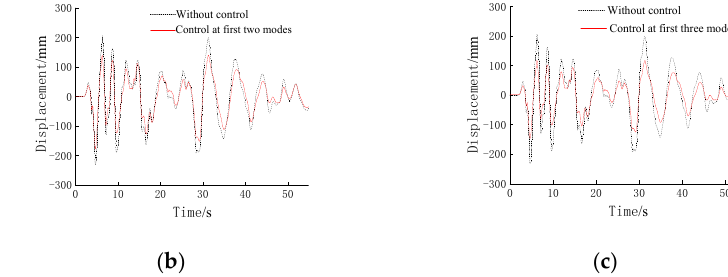
Figure 17. Time history of displacement by optimized control at different modes under the El-Centro seismic record. ( a ) First mode. ( b ) First two modes. ( c ) First three modes.